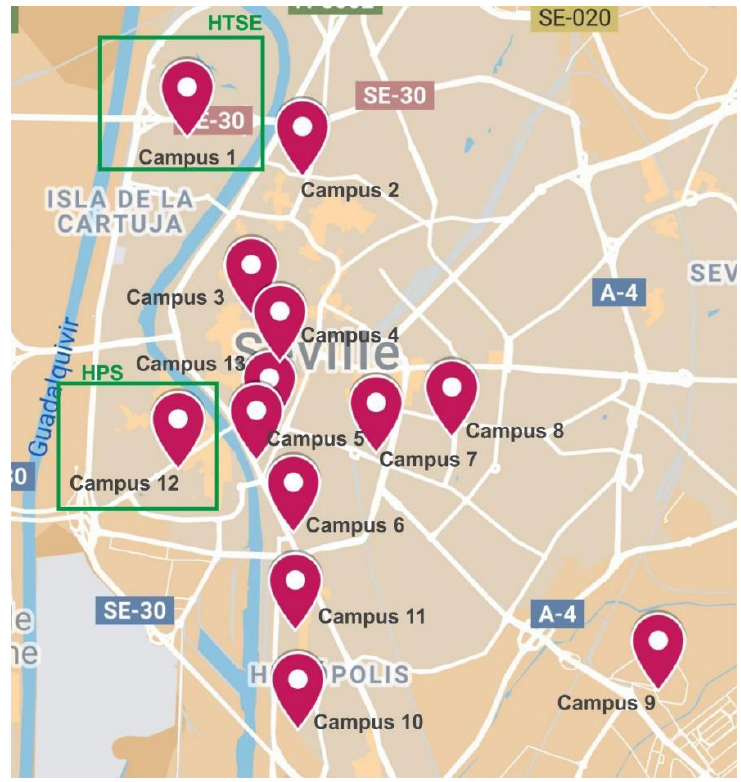
Figure 2. Campus distribution of the University of Seville [32,33].